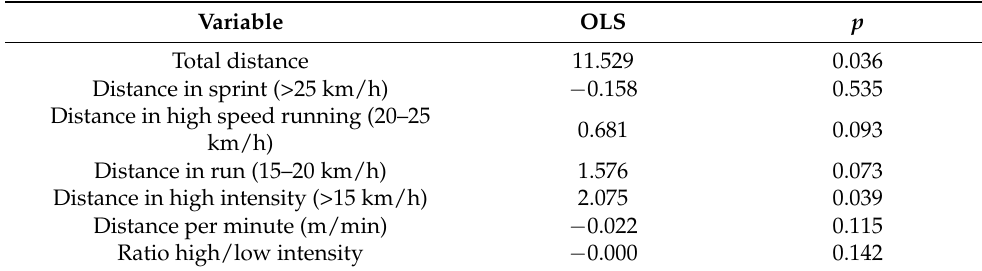
Table 3. Correlation between rMSSD and match performance. Fixed effects Ordinary Least Squares (OLS) regression results. Time dummies were included in the estimates but not reported. Observations =